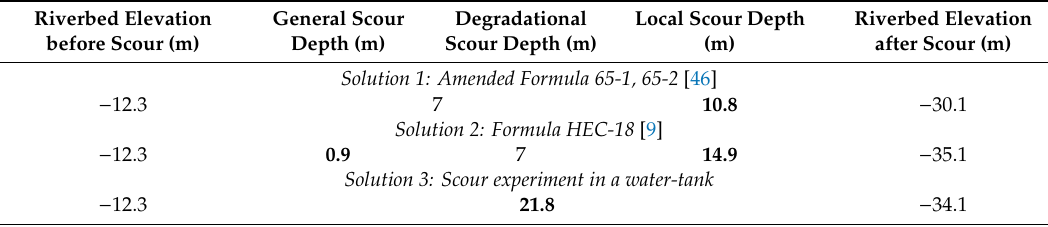
Table 1. Predicted results of scour depths (Pylon number: B10 /